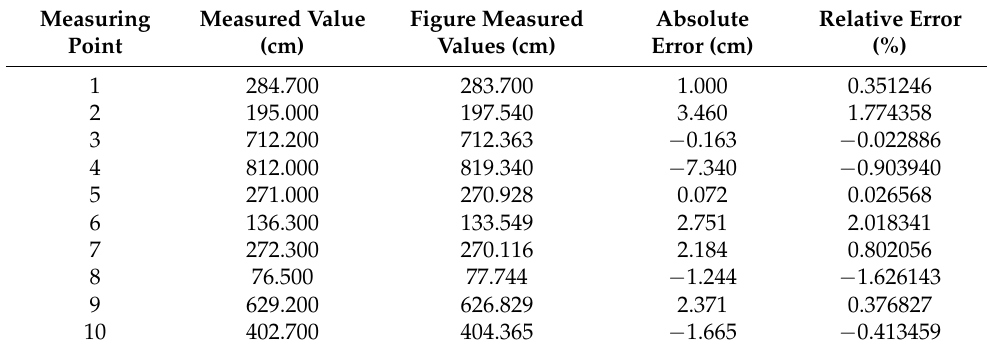
Table 3. Iao_ICP algorithm mapping error table.